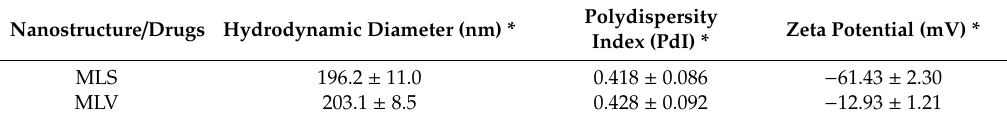
Table 1. Physical-chemical properties of the di ff erent nanostructures.